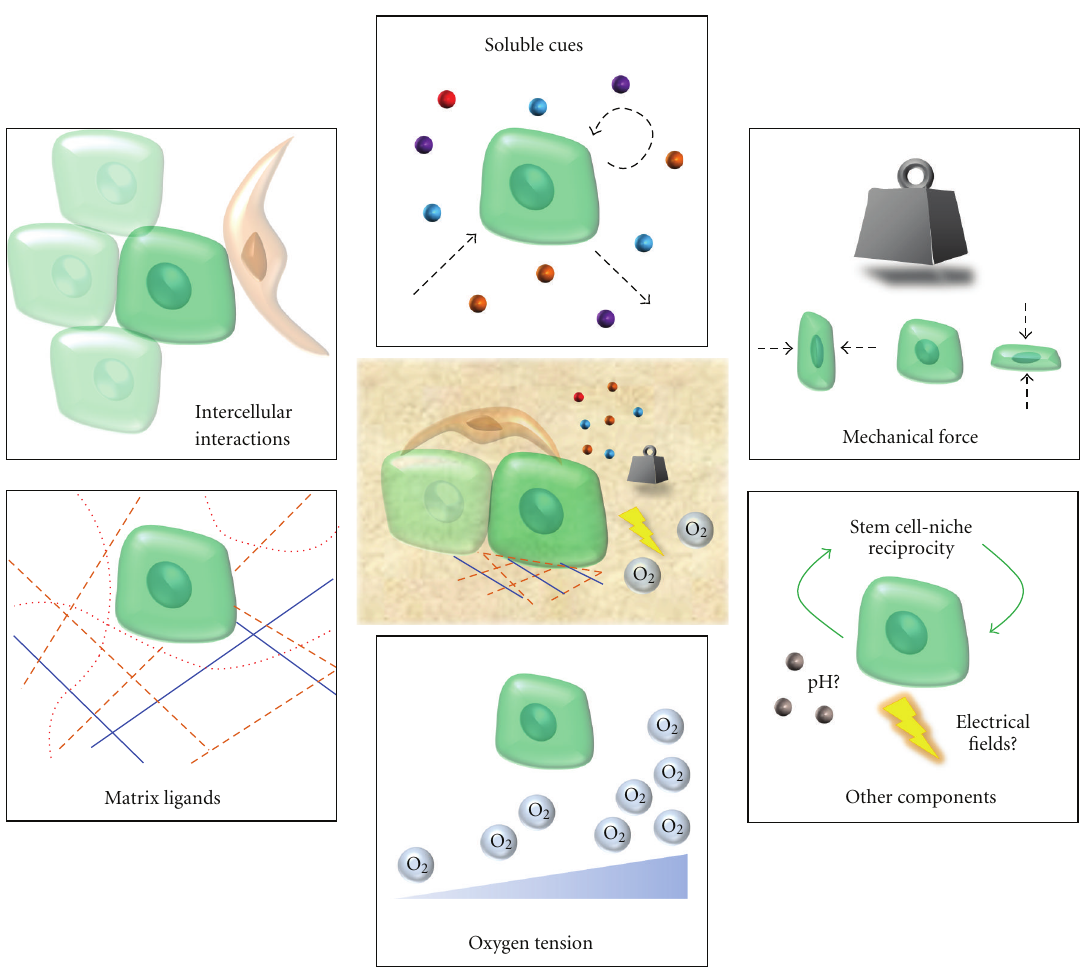
Figure 1: Potential components of the skin stem cell niche. Features common to skin stem cell niches include dynamic regulation of matrix ligands, intercellular interactions, and biochemical gradients in the appropriate three-dimensional contexts. Engineered biomaterials o ff er the potential to e ff ectively pattern and regulate these biologic cues on increasingly precise time and space